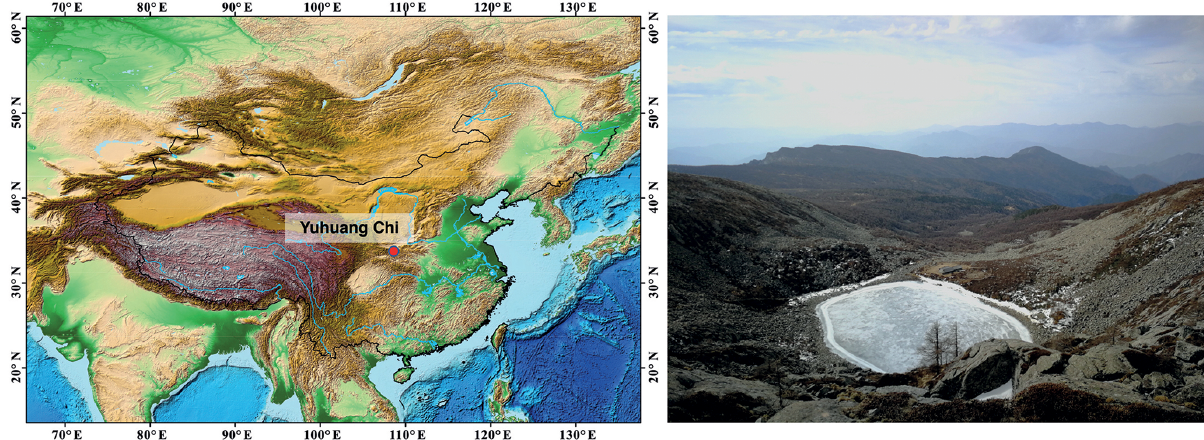
Figure 1. Regional position of Yuhuang Chi lake in the Qinling mountains of central Asia. The lake is situated 3370ma.s.l., and it was formed by glacial activity. The photograph of the frozen lake to the right shows the small catchment and tundra